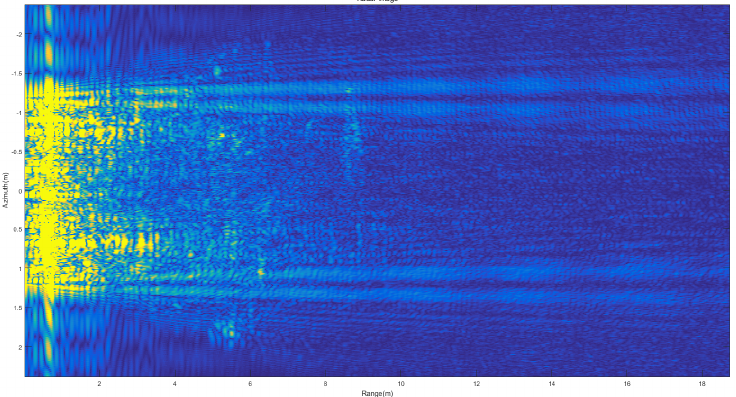
Figure 8. Static Kelvin wake radar image.